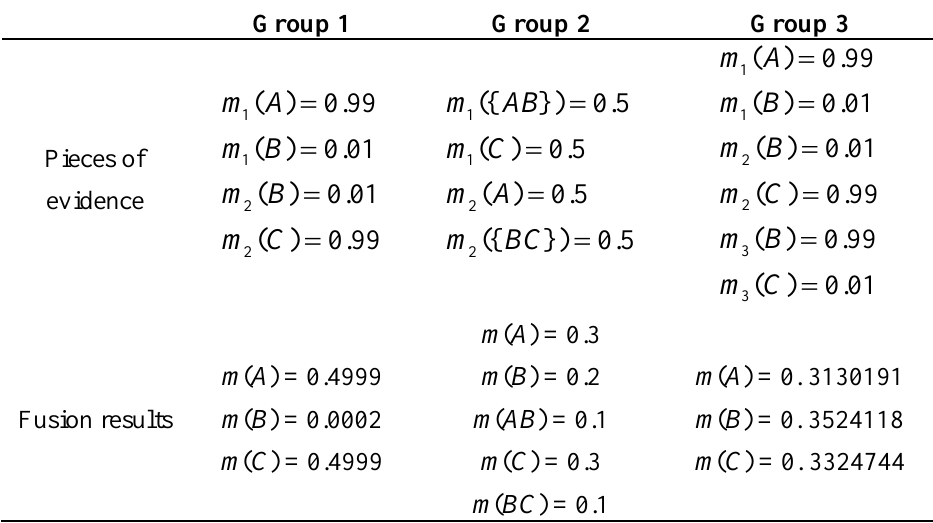
Table 3. Fusion results for proposed method in different